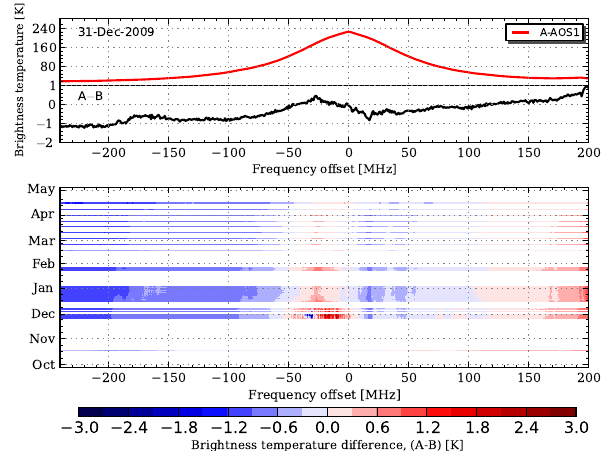
Fig. 5. Difference between the calibrated O 3 spectra of Band-A and Band-B from the SMILES L1b version 007. Top panel shows an averaged radiance over ten spectra for a tangent height around 30km observed with Band-A, and the difference from that of Band- B (an average of ten differences calculated from each A–B pair). Ten scans were selected from the equatorial region measurements (30 ◦ S–30 ◦ N) on 31 December 2009. The horizontal axis is the fre- quency offset from 625.371GHz. Bottom panel contour plot rep- resents the temporal change of the radiance difference around the tangent height of 30km. The blank region in the lower panel is the dates when SMILES was not operated in the A + B configuration.